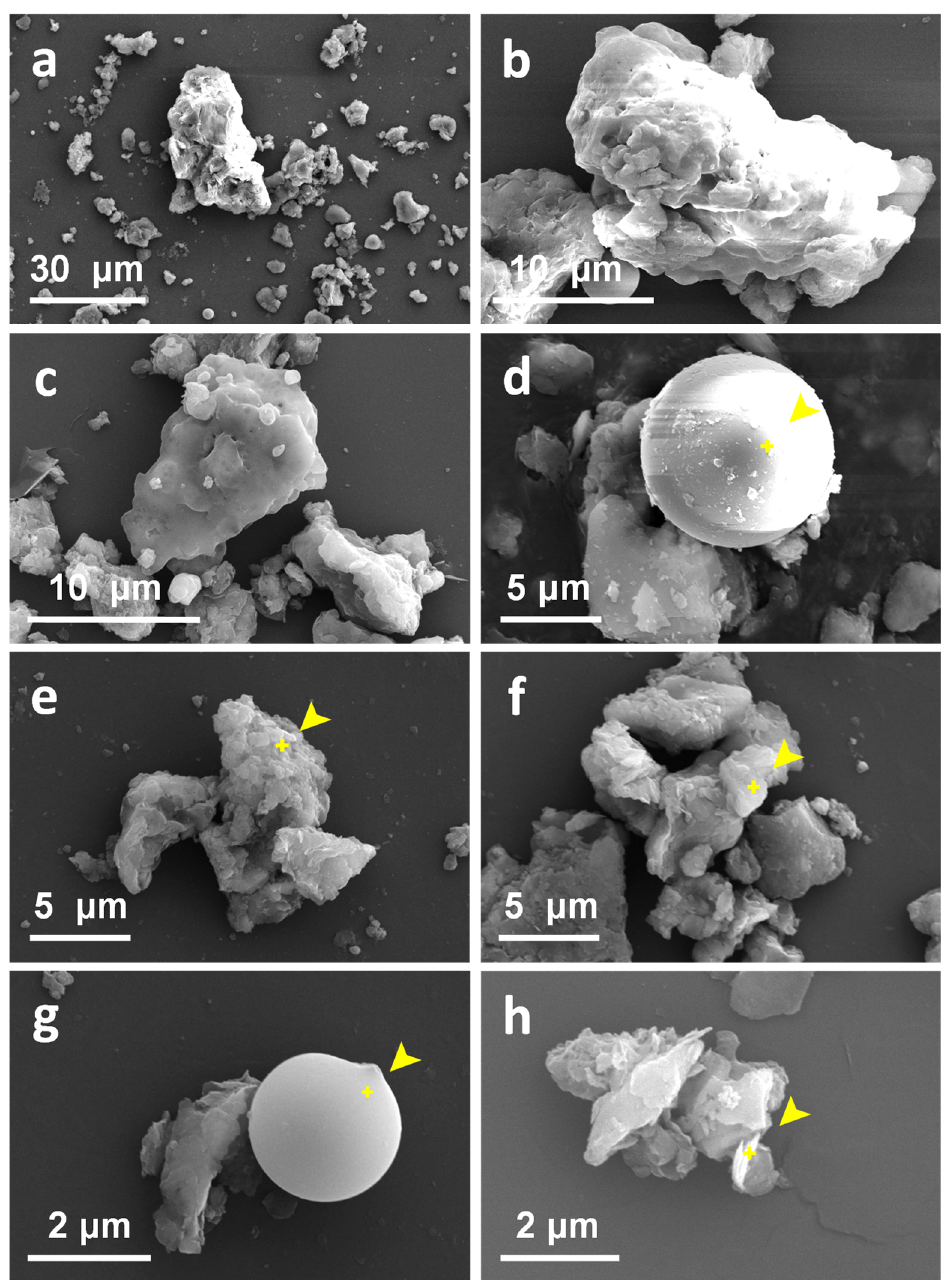
Figure 5. SEM images of baghouse filter dust particles . SEM images at ×1000 in ( a ); ×4000 in ( b ) and ( c ); ×5000 in ( d – f ); and ×15,000 in ( g , h ). The energy spectra of the points (marked in yellow) in ( d – h ) show the main component compositions of the particles: ( d ) O (50%), Si (19%), C (9%), Al (8%), and Ca (5%); ( e ) C (41%), O (30%), Si (23%), Al (2%), and Mg (1%); ( f ) O (48%), Si (22%), C (20%), Al (5%), and Na (4%); ( g ) O (50%), Si (26%), C (10%), Al (7%), and Fe (3%); and ( h ) Si (40%), O (34%), C (20%), Al (4%), and Fe (1%).